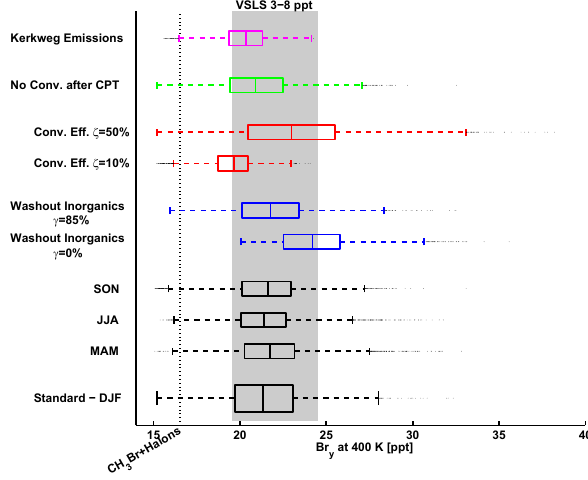
Fig. 9. Boxplots illustrating the different distributions of Br y arriv- ing at 400K from all trajectories traversing the TTL in 2000. The boxes illustrate the 25-th to 75-th percentiles, the whiskers 1.5 × the interquartile range and the crosses outliers. Unless otherwise stated the distributions are for DJF, using Yokouchi et al. (2005) boundary layer concentrations, a 30% BL component to the con- vective outflow, and washout at the CPT of 100%. The lowermost bar is this standard case, and all other bars show the sensitivity to the resultant Br y for the indicated change. The dashed line provides the Halons+CH 3 Br contribution for 2000 (WMO, 2006, Table 8– 5) and the grey shaded region the WMO recommendation for an additional VSLS contribution of 3–8ppt (WMO, 2006, Table